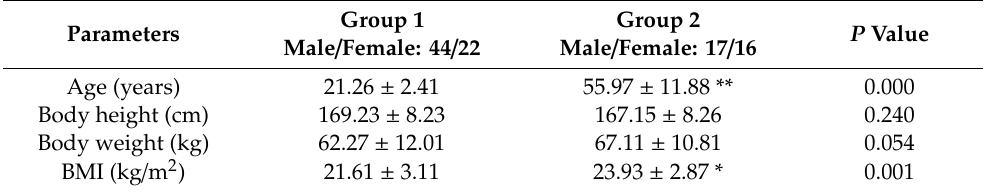
Table 1. Comparison of demographic and anthropometric parameters between young and upper middle-aged